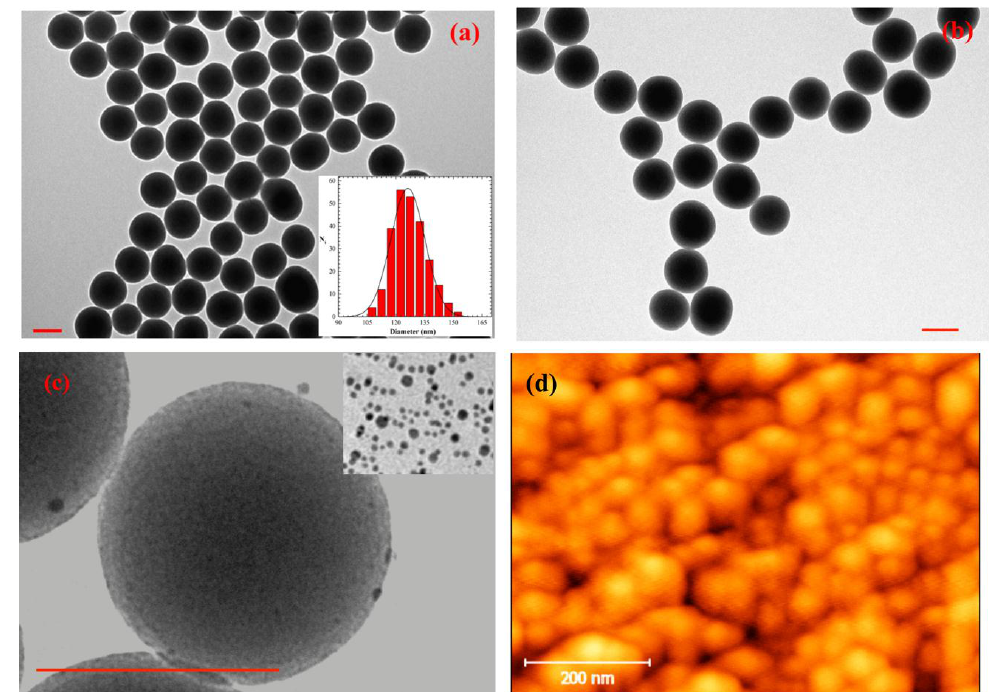
Figure 1. Transmission electron microscopy (TEM) images of SiO 2 ( a ), inset size distribution histogram), N-SiO 2 ( b ), and Ag-SiO 2 ( c ), inset: TEM image of dodecanethiol-stabilized silver nanoparticles (DDT-Ag nanoparticles); ( d ) Atomic force microscopy (AFM) image of SiO 2 nanoparticles deposited on cover glass after washing procedure. Scale bars are 200